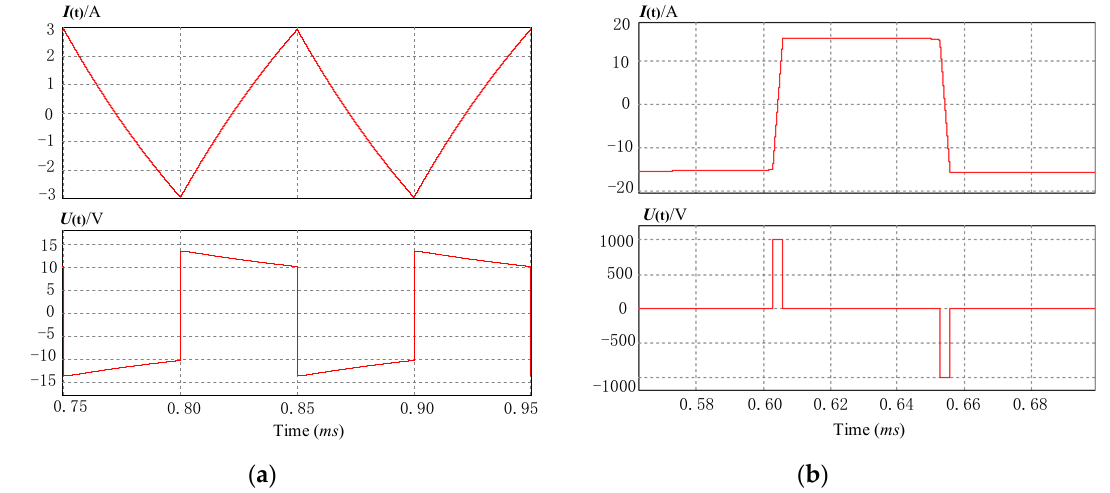
Figure 8. Waveforms of the output current and voltage, 10 KHz. ( a ) Traditional full-bridge circuit; ( b ) Constant current and voltage clamping control circuit.